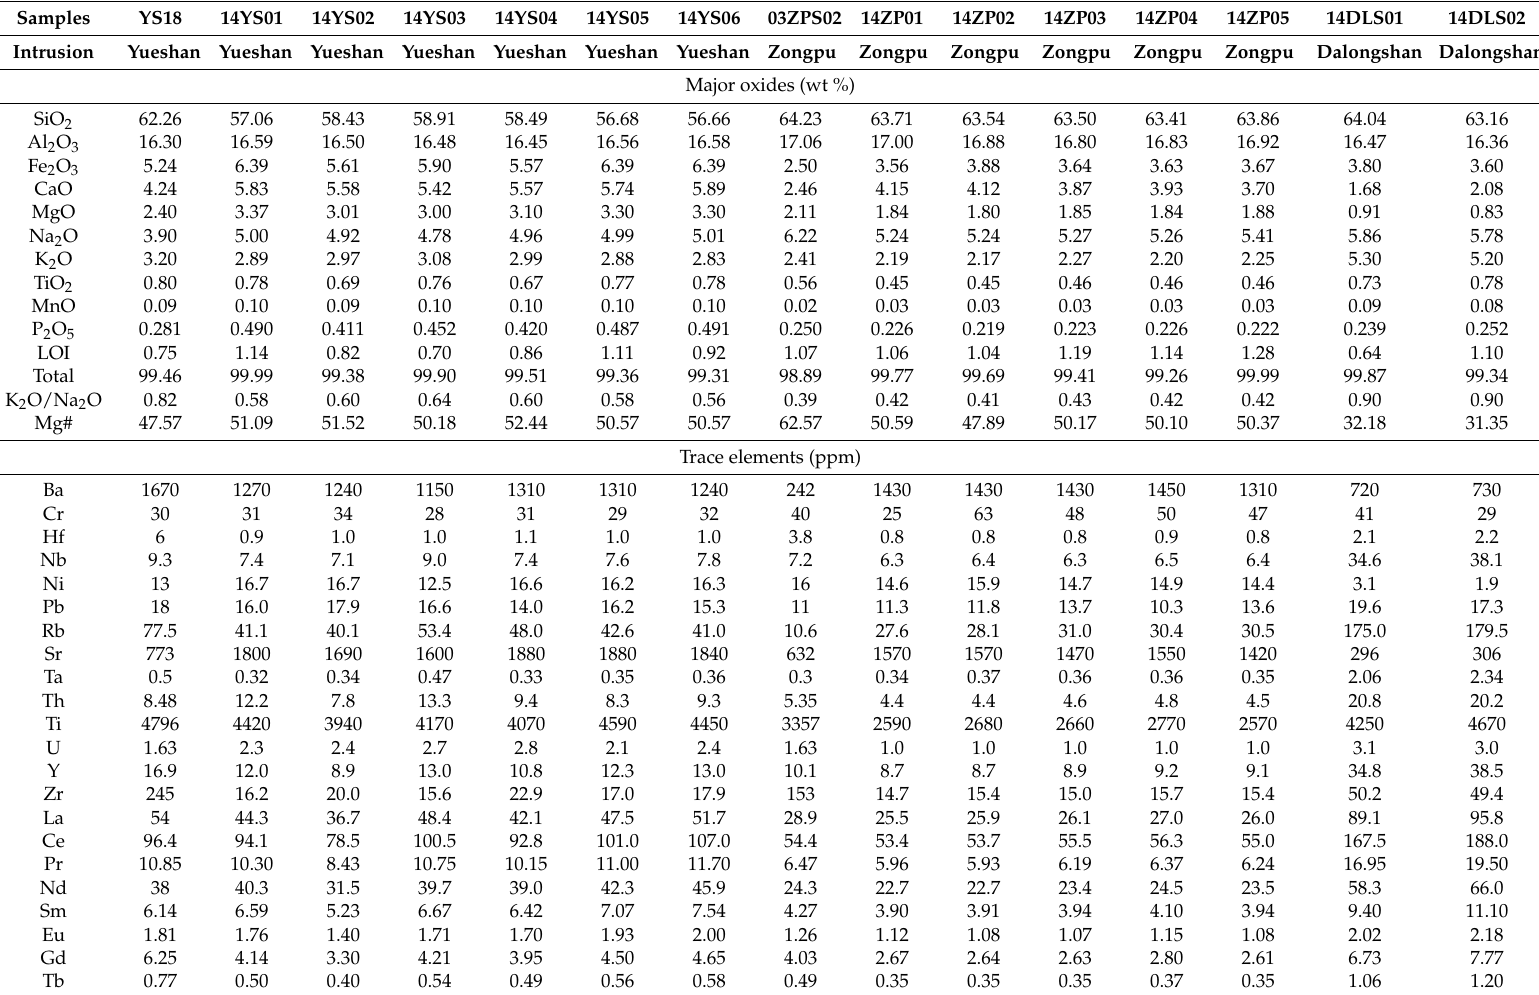
Table 1. Major and trace element compositions of the Yueshan, Zongpu and Dalongshan intrusions in the Anqing orefield.